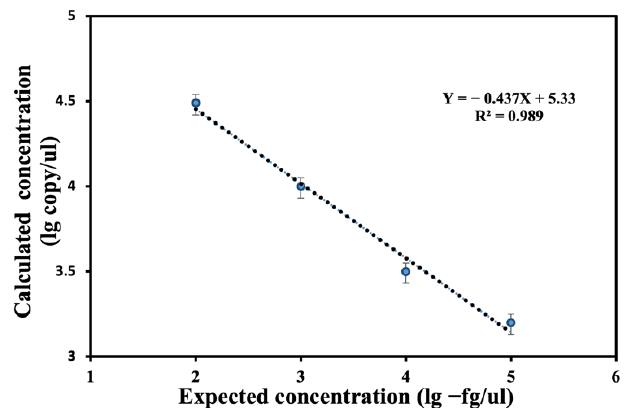
Figure 5. The correlation between the calculated concentration and the expected concentration of